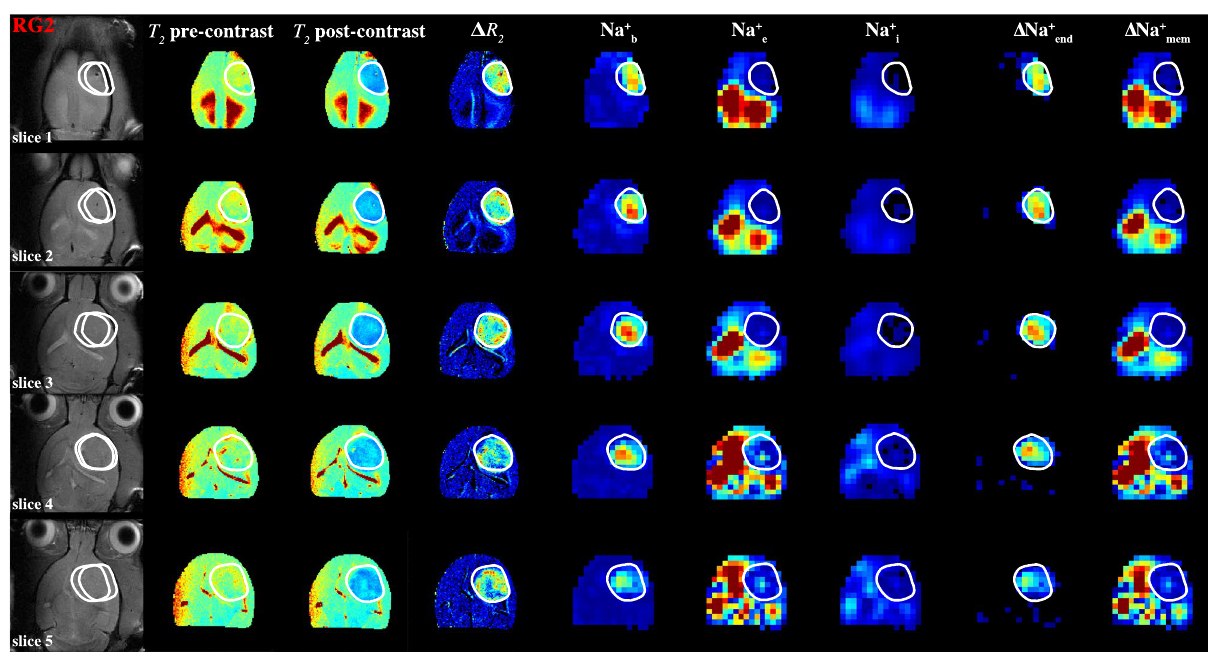
Figure 4. Spatial distributions of compartmentalized 23 Na signals (Na + b , Na + e , Na + i ) as well as transendothelial (ΔNa + end ) and transmembrane (ΔNa + mem ) gradients in an RG2 tumor. The high-resolution 1 H-MRI data are shown in the left four columns, whereas the lower resolution 23 Na-MRSI data are shown in the next five columns on the right. The left column shows the tumor location (white outline) on the anatomical 1 H-MRI (left), whereas the next two columns show the T 2 maps (range shown: 0–100 ms) before and after TmDOTP 5− injection, and the subsequent column depicts the ∆ R 2 map (i.e., difference between 1/T 2 maps before and after, range shown: 0–30 s −1 ), which is proportional to [TmDOTP 5- ] in healthy and tumor tissues. Since ∆ R 2 values are more heterogeneous within the tumor, the 23 Na-MRSI data are needed to separate the blood and extracellular compartment signals for the tumor. Since the integral of each 23 Na peak represents the [Na + ], the respective three columns show the integral maps of Na + b , Na + e , and Na + i from left to right (i.e., ∫ Na + b , ∫ Na + e , ∫ Na + i ). The last two columns on the right show ΔNa + end = ∫ Na + b - ∫ Na + e and ΔNa + mem = ∫ Na + e - ∫ Na + i . The ∫ Na + b map reveals low values in healthy tissue compared to tumor tissue, and within the tumor boundary a high degree of heterogeneity. The ∫ Na + e map reveals low values in tumor and normal tissues, but within the tumor boundary a small degree of heterogeneity is visible while ventricular voxels show very high values. The ∫ Na + i map reveals low values ubiquitously except some ventricular voxels. The ΔNa + end map reveals dramatically high values within the tumor only. The ΔNa + end was driven primarily by an increase of ∫ Na + b inside the tumor and which was more pronounced in superficial regions of the brain compared to deeper slices. The ΔNa + mem map shows low values in tumor tissue compared to normal tissue, although ventricular voxels show very high values. The ΔNa + mem is driven primarily by decreased ∫ Na + e and thus shows similar level of heterogeneity as the ∫ Na + e map. All maps use the same color scale and are relative. See Figure S4 for an example for a U87